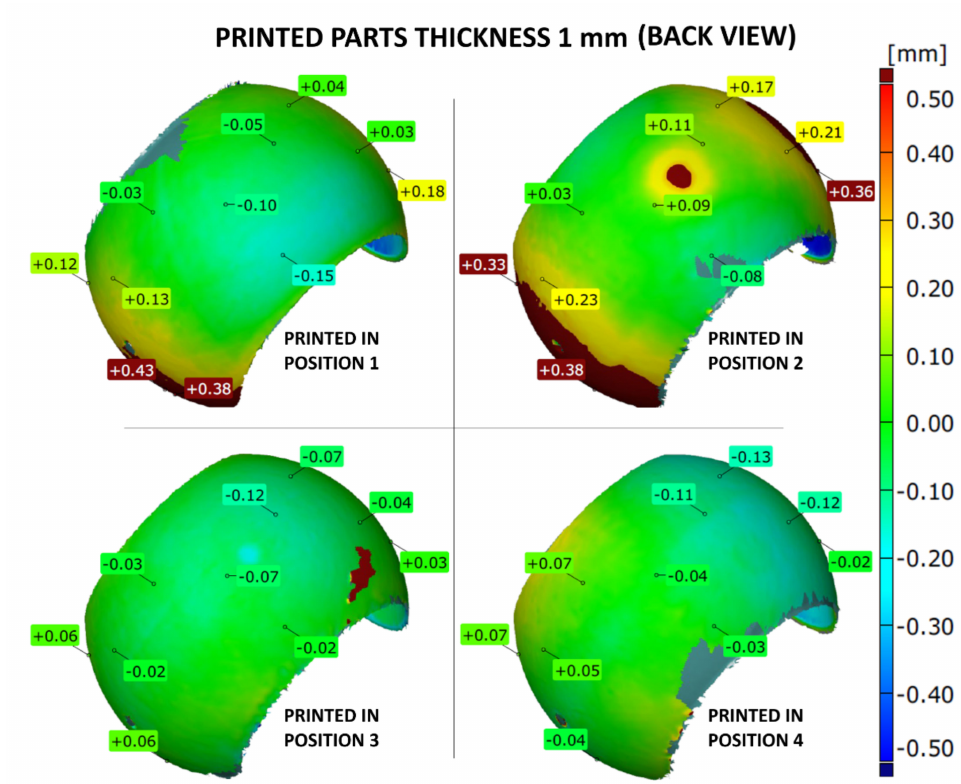
Figure 8. Geometry deviations of the 3D printed part with a thickness of 1 mm (back view).